Question: Briefly state, in one sentence, what is plotted here.
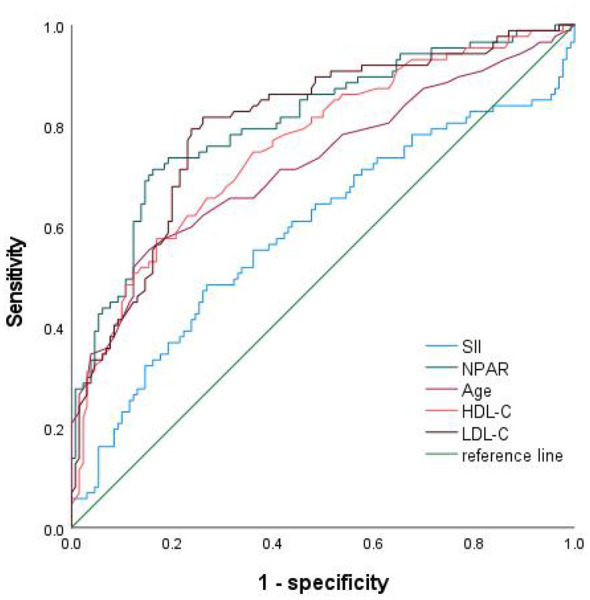
Answer: ROC curves of different indicators associated with chronic subdural hematoma.